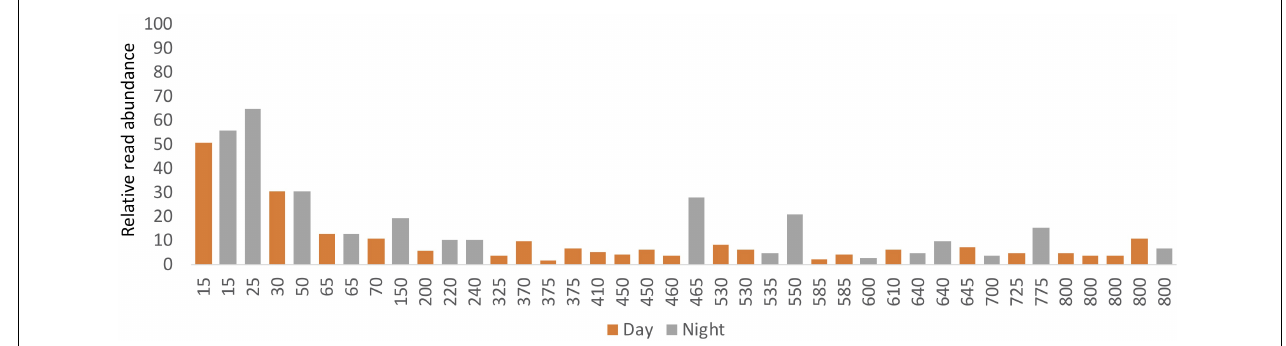
FIGURE 4 | Relative read abundances from ASVs classified as metazoans in the eDNA samples vs. depth.